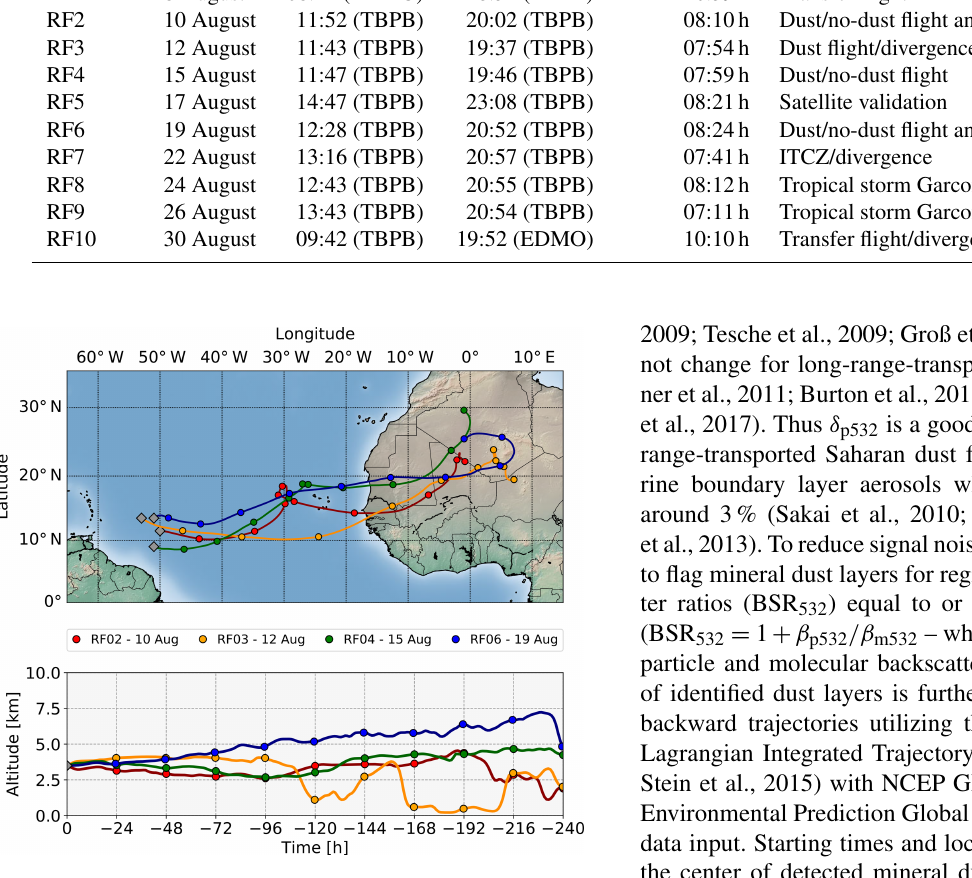
Figure 2. The 10d backward trajectories with starting points at the center of the respective Saharan air layers for the four NARVAL-II research flights leading over Saharan-dust-laden trade wind regions (RF2, RF3, RF4 and